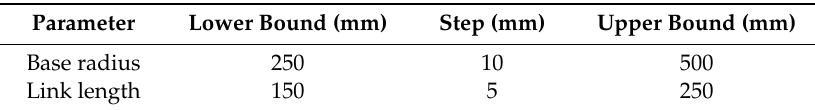
Table 1. Optimization